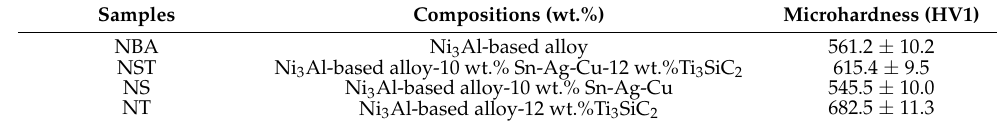
Table 2. Compositions and microhardness of the as-prepared samples. Table 1. Chemical compositions of Ni 3 Al-based alloy (wt.%).